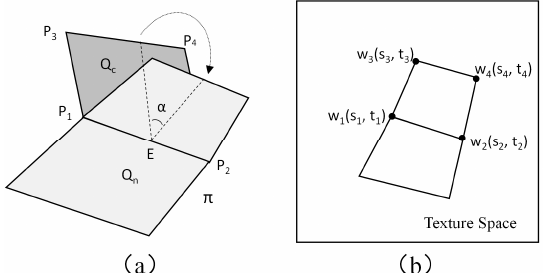
Figure 10. Possible configurations for different constraint values (CVs).